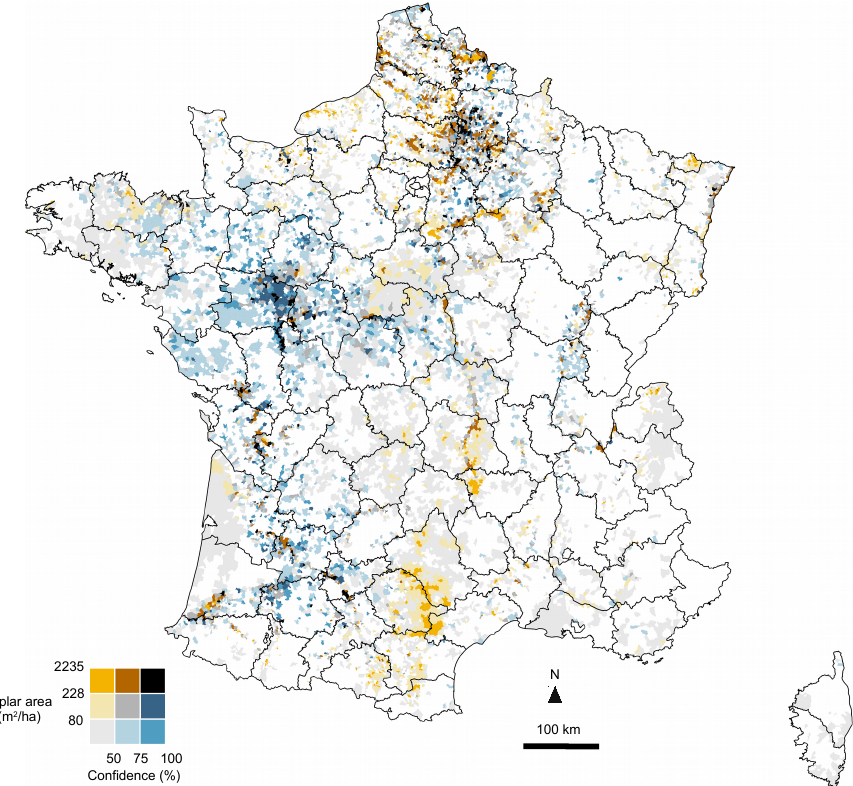
Figure 13. Bivariate choropleth map of France showing the density of poplar plantations in each municipality with the median prediction confidence values for the year 2018. The map was produced from the PI 2 index using each image of the 2018 S2 time series (10-day frequency after resampling). Municipalities with no plantations or with a planted area of less than 5 ha are in white. The black lines represent the administrative boundaries of the 96 French departments. Non-forest areas were masked using the 10 m Copernicus HRL 2018 forest